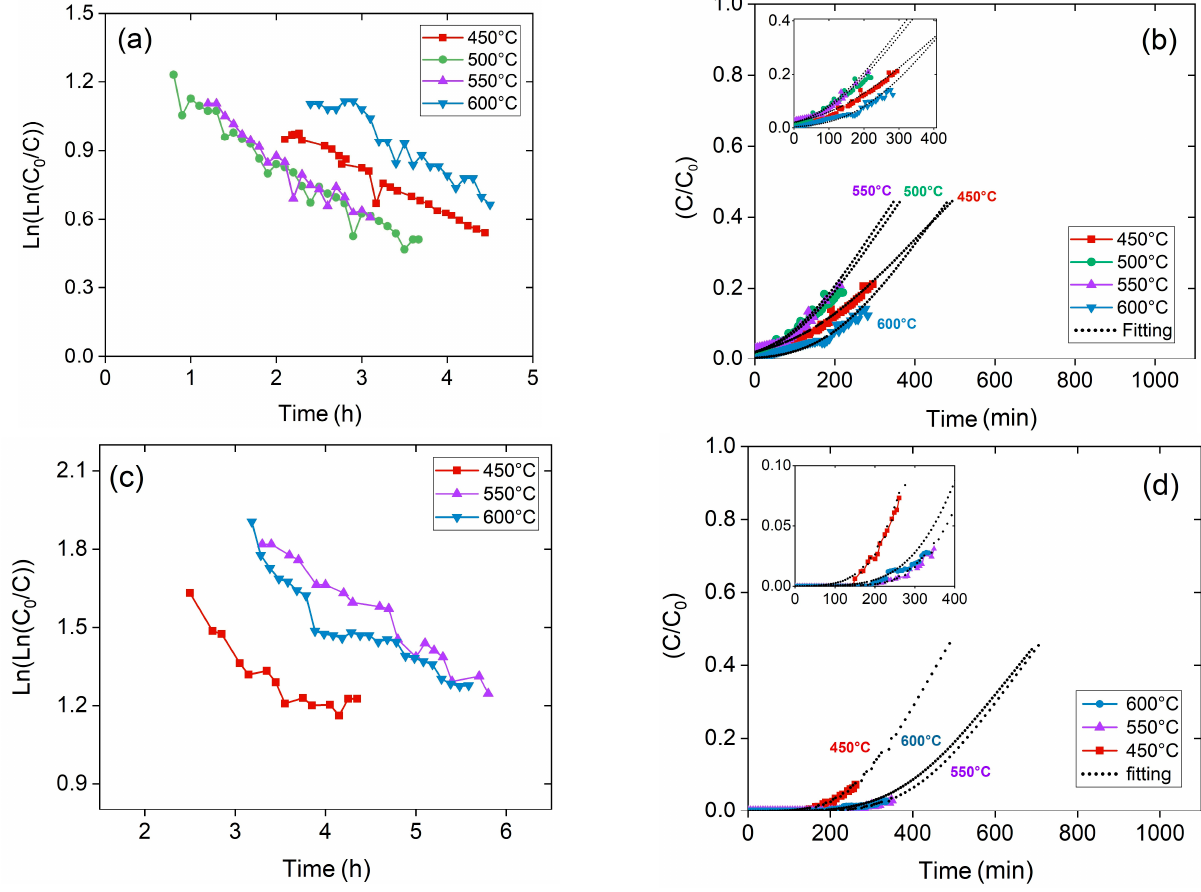
Figure 4. Linearized deactivation kinetic model ln(ln(C 0 /C)) vs. time and breakthrough curves fitting ( a , b ) calculated by using GHSV equal to 50,000 (upper) at 450, 500, 550, and 600 °C and linearized deactivation kinetic model ln(ln(C 0 /C)) vs. time and breakthrough curves fitting ( c , d ) calculated by using GHSV equal to 25,000 h − 1 (lower) at 450, 550, and 600 °C.